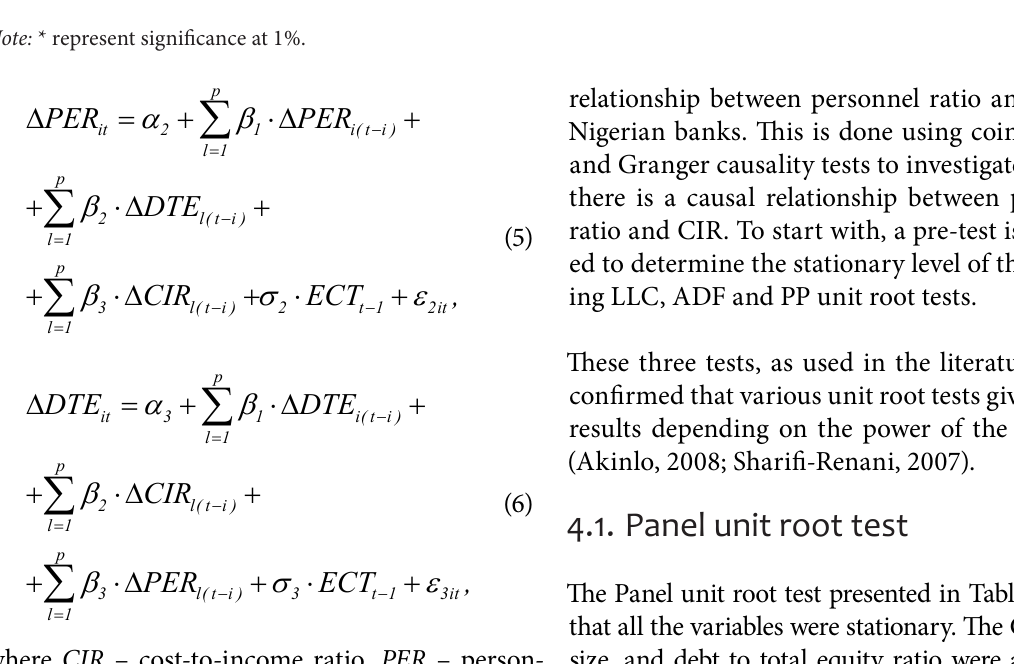
Table 1. Panel unit root test at first difference I (1) for the variables